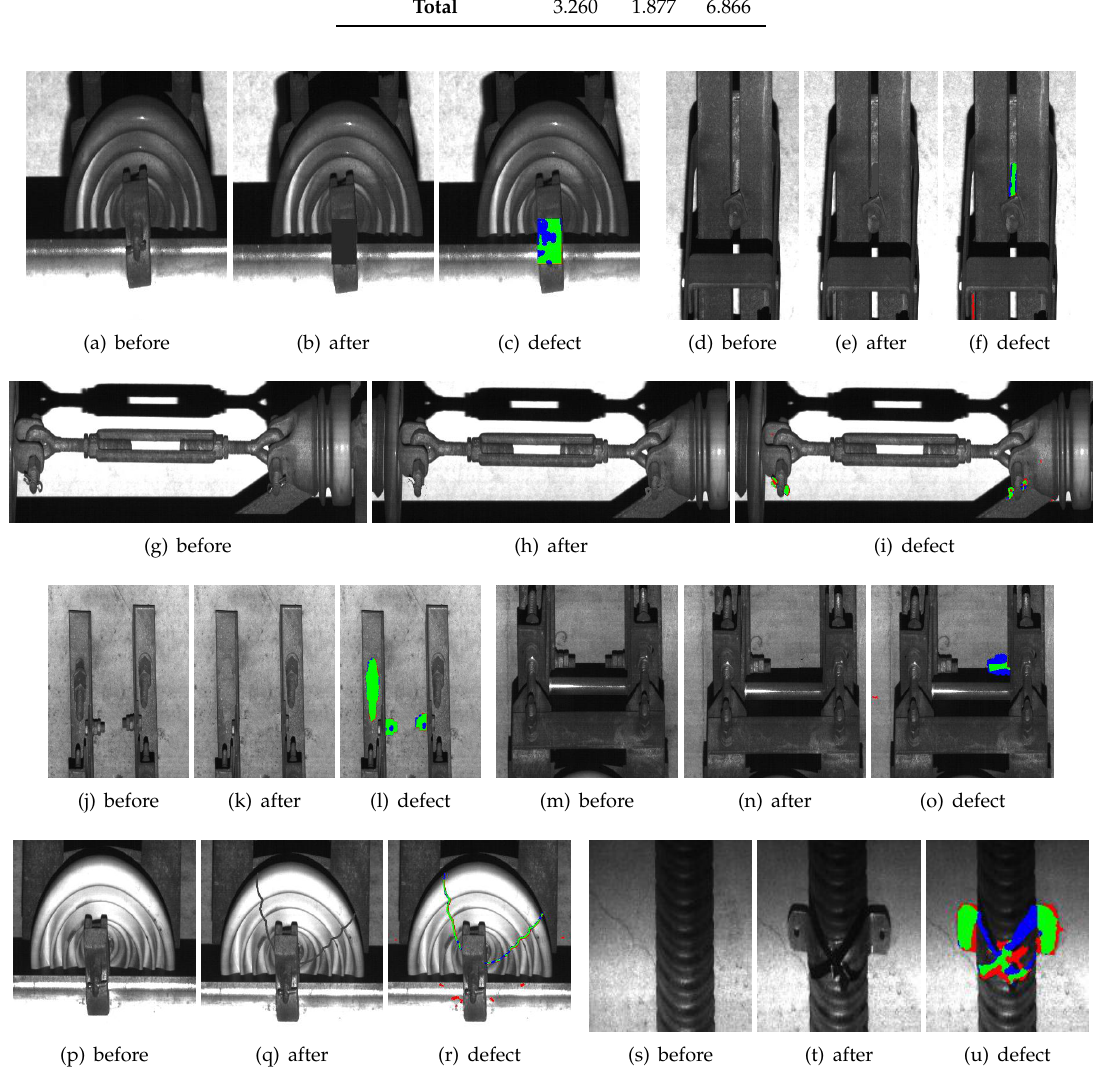
Figure 14. Results of deformed regions using the proposed system. Green, blue, and red color represent true positive, false negative, and false positive,